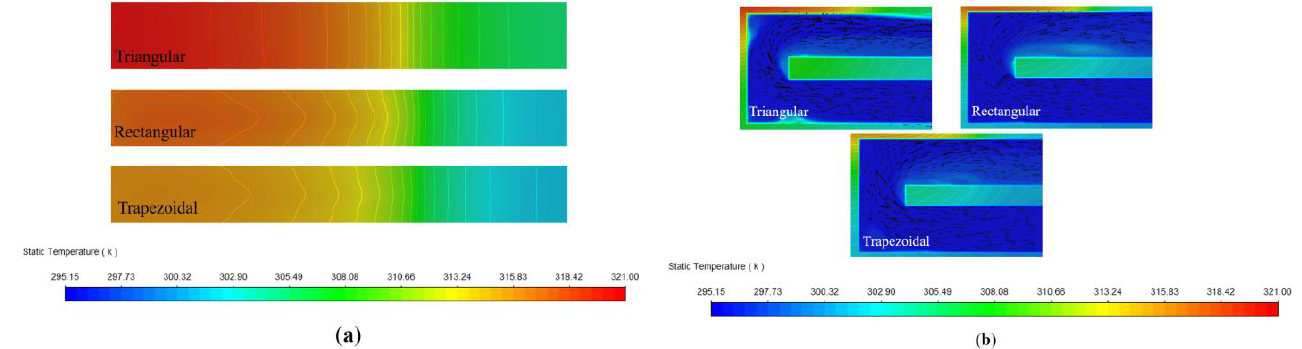
Figure 12. Comparison of local heat transfer coefficients under the same hydraulic diameter (0.417 mm. W pp = 0.27 W).